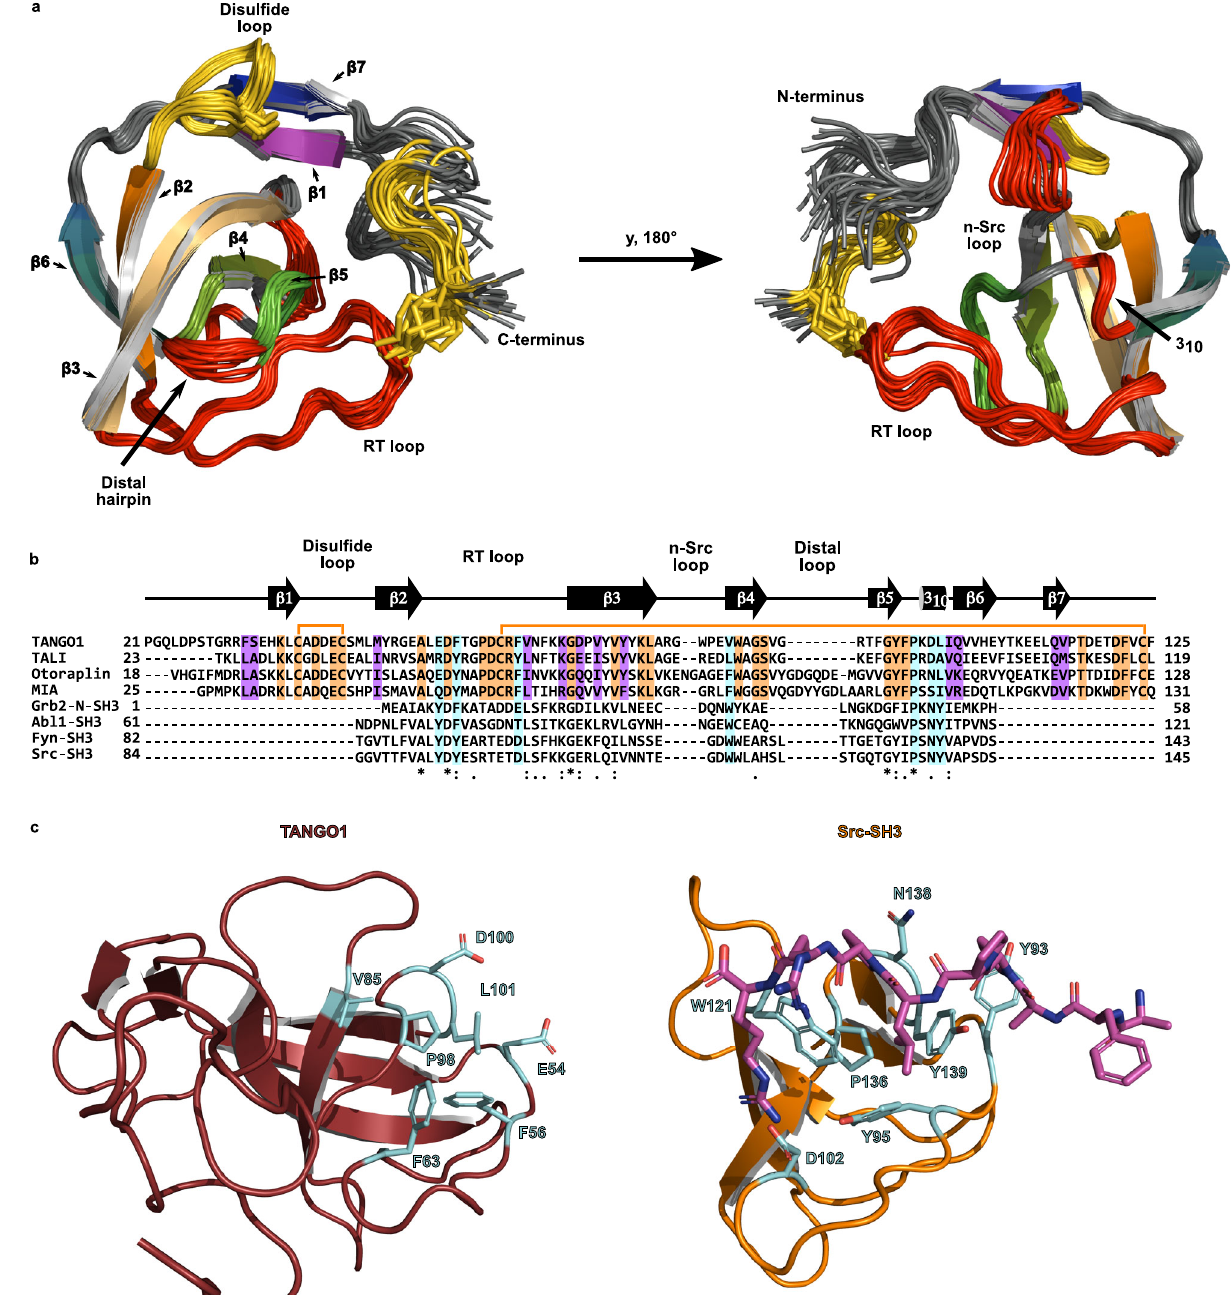
Fig. 1 | TANGO1 ’ s cargo-recognition domain adopts a modi fi ed small β -barrel fold without retaining functional residues of SH3 domains. a Structure ensemble of human TANGO1 ’ s cargo-recognition domain solved by solution NMR spectroscopy. Features also present in SH3 domains are highlighted in red, new features created by extended termini in yellow. Disul fi de bridges are shown as sticks. (See also Supplementary Table 1) b Multiple sequence alignment of the members of TANGO1 protein family and SH3 domains performed with Clus- talOmega.SecondarystructureelementsofTANGO1 ’ sdomainaredisplayedabove; disul fi de bridges are represented by orange lines. Conserved and semi-conserved